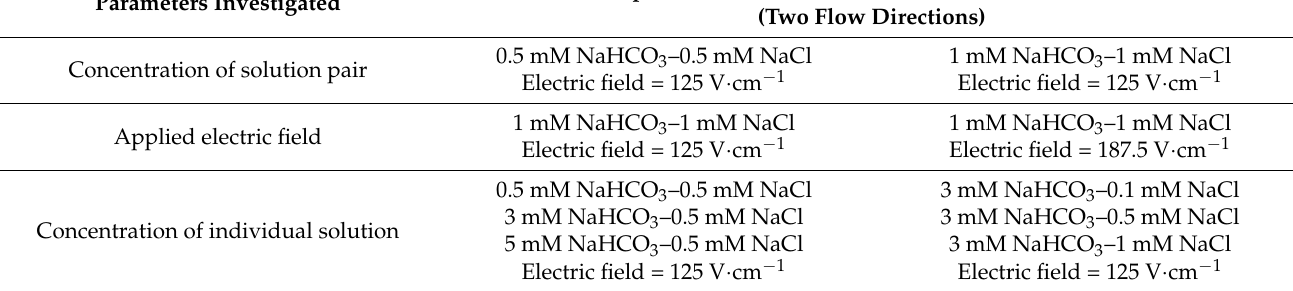
Table 1. Experimental conditions with parameter variations for electroosmotic displacement flow of sodium bicarbonate (NaHCO 3 ) and sodium chloride (NaCl) solution pair in two flow directions, i.e., NaCl → NaHCO 3 (arrow indicates EOF direction), and NaHCO 3 →